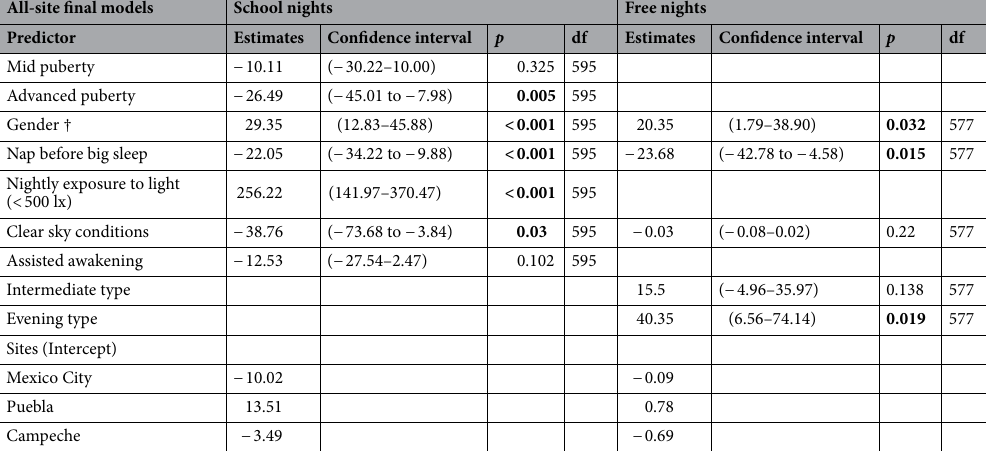
Table 5. Bio-socio-cultural predictors of sleep duration variation on school nights and free nights across locations. Negative coefficients indicate decreased sleep durations, while positive coefficients higher sleep durations. † Boys are the reference category for gender; the estimates are for girls. Significant values are in bold.